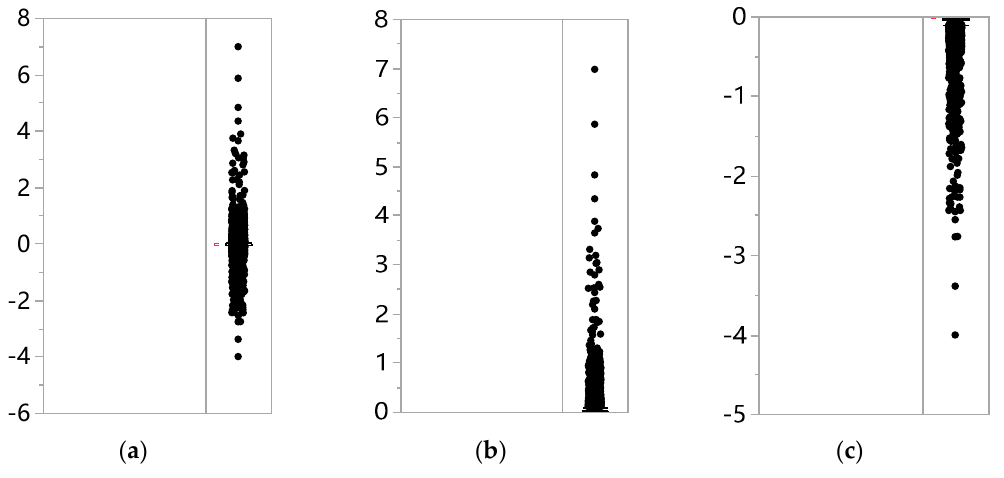
Figure 7. Amplitude distribution of the ( a ) whole micro-texture; ( b ) positive micro-texture; ( c ) negative micro-texture.